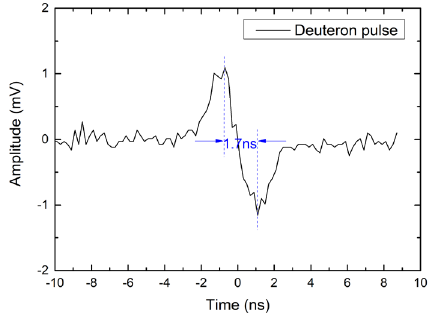
Figure 1. Schematic layout of the acceleration system and exper- imental beamlines after the upgrade, the new devices are high- lighted in blue.